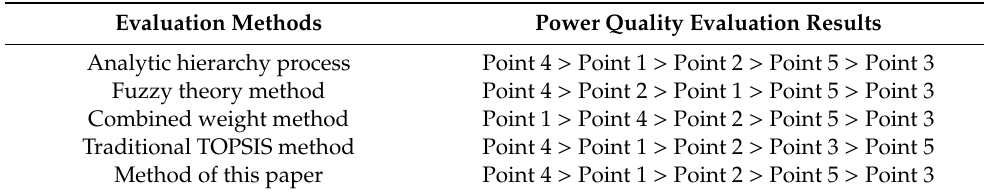
Table 8. Comparison of results of each evaluation